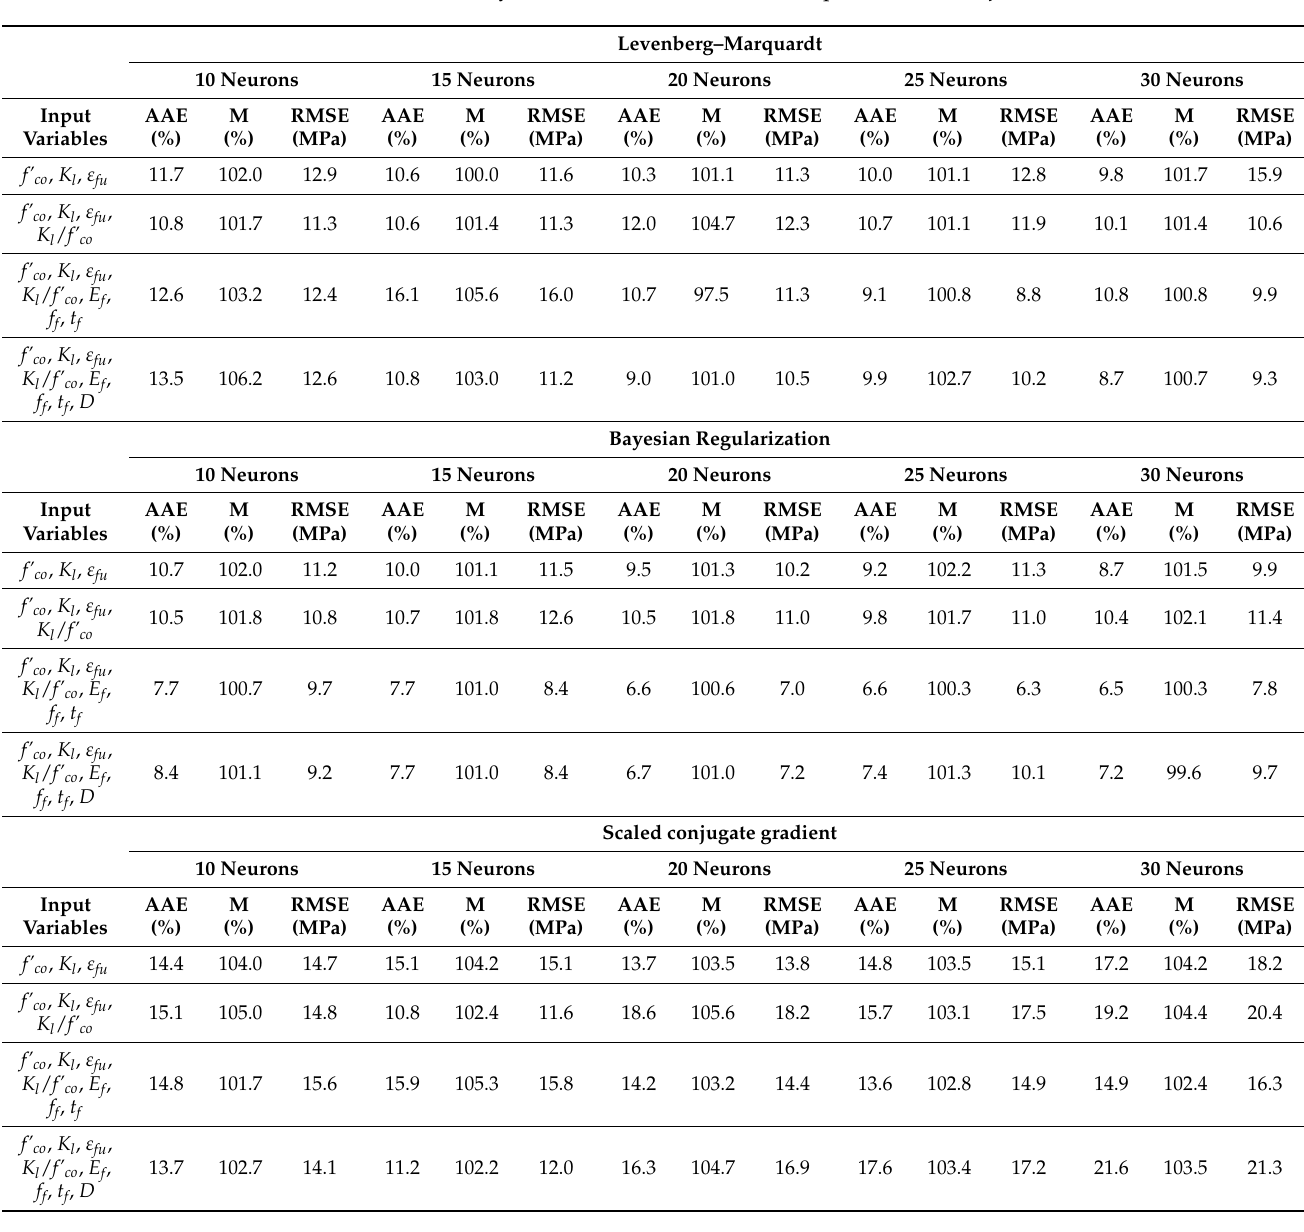
Table 3. Summary of different studied cases for input variables for f’ cc